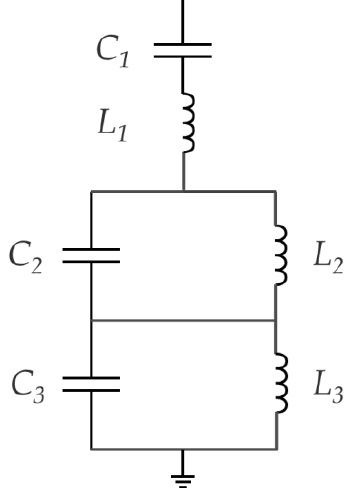
Figure 3. The direct triple-tuned filter.